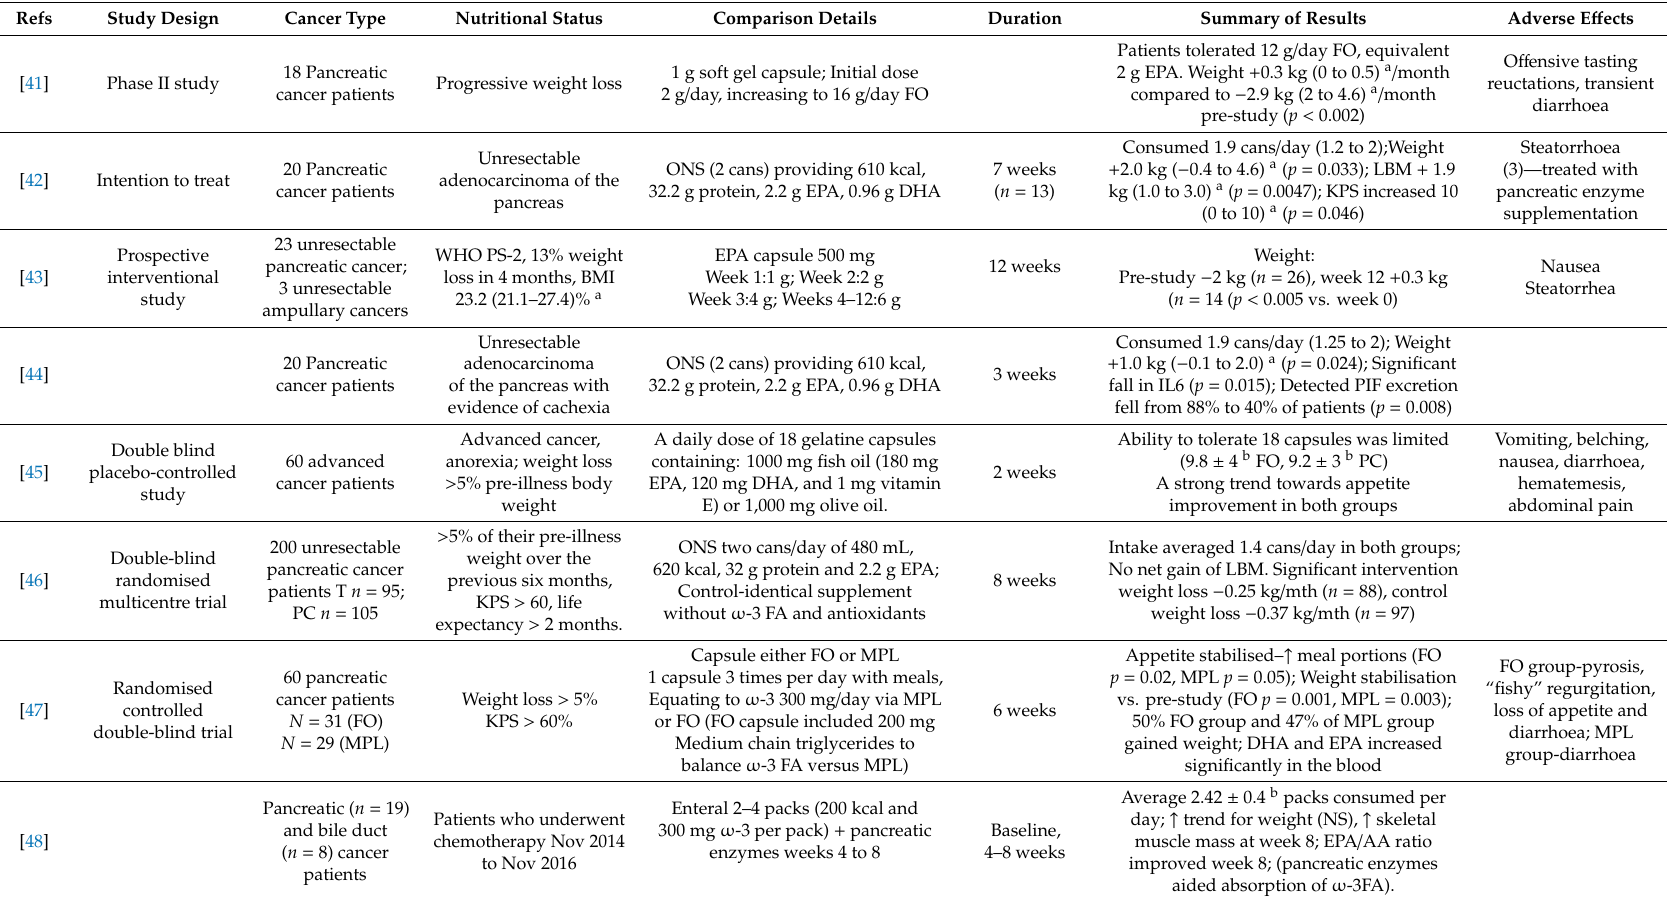
Table 2. Summary of studies involving pancreatic cancer patients receiving fish oil